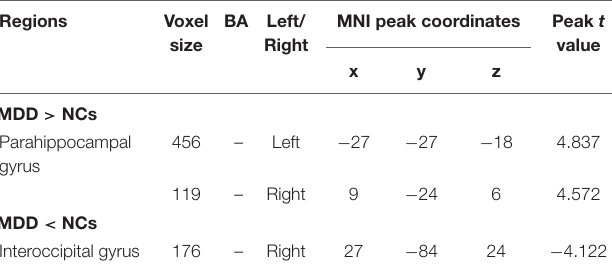
TABLE 3 | | ReHo of brain regions showing significant difference between patients with major depressive disorder (MDD) and normal controls. Regions Voxel BA Left/ size